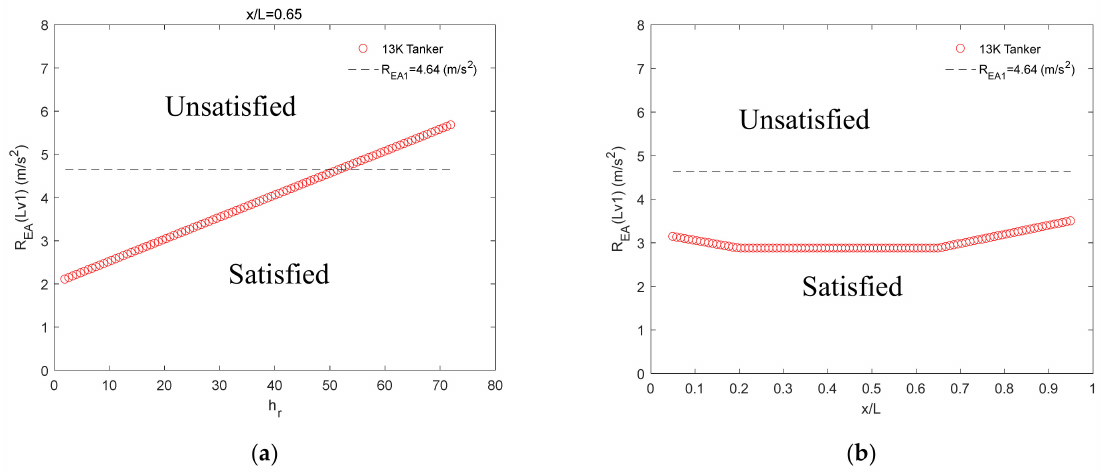
Figure 4. Lv1 vulnerability criterion assessment for excessive acceleration mode of the 13 K oil chemical tanker. ( a ) x / L = 0.65, ( b ) h r = 16.998